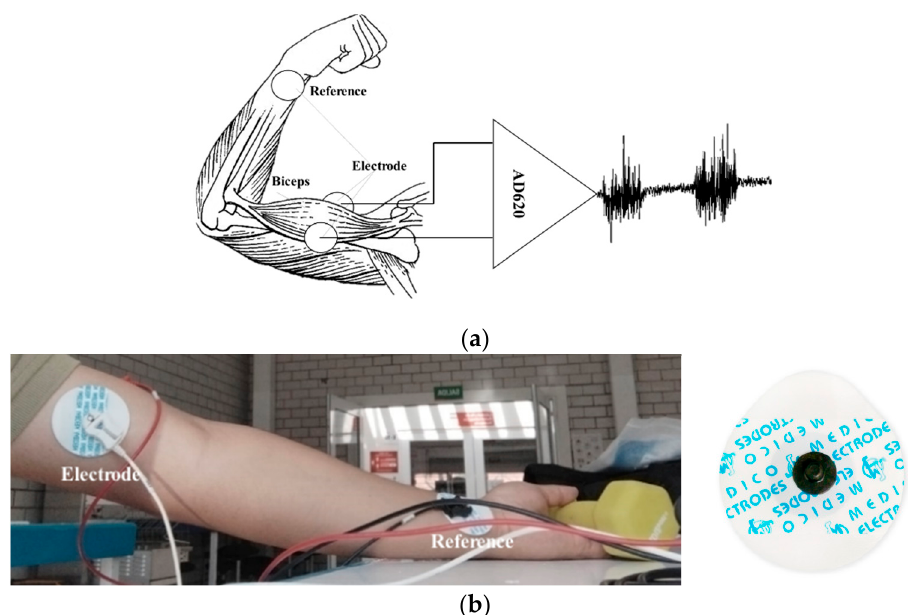
muscles to achieve their contraction. The differential potential in the biceps brachii is measured by placing two silver/silver chloride (Ag/AgCl) electrodes and a reference electrode located at the junction of the forearm and hand, as shown in Figure 2. [20].